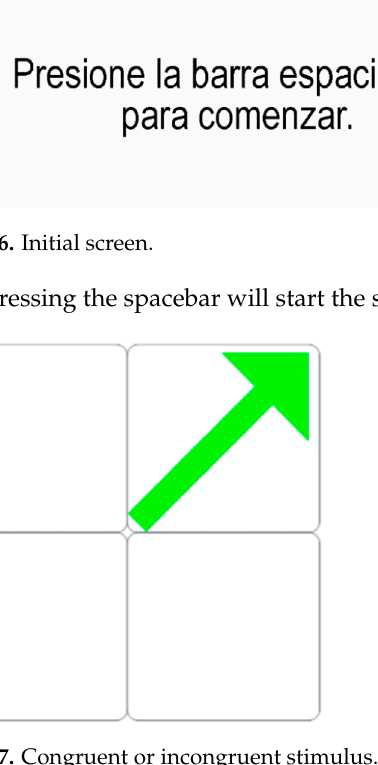
Figure 7. Congruent or incongruent stimulus.